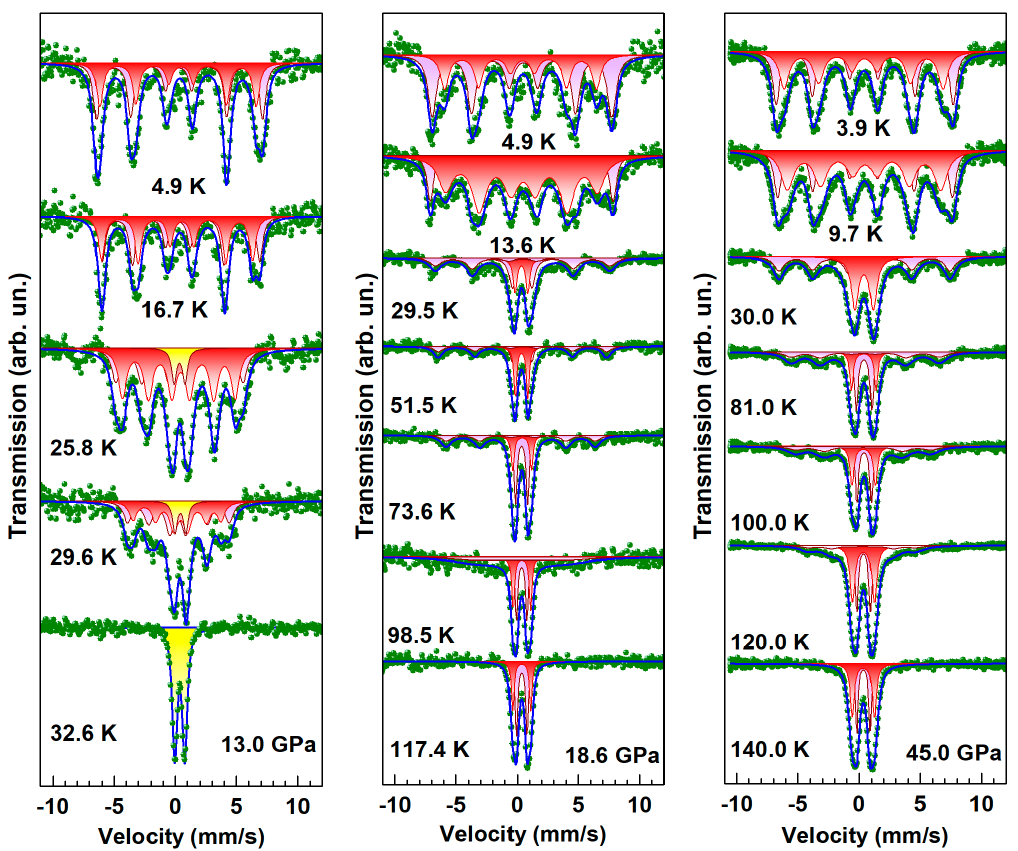
Figure 7. (Colour on-line) Evolution of SMS spectra with temperature in Ba 3 NbFe 3 Si 2 O 14 at pressures below (13.0 GPa) and above (18.6 and 45.0 GPa) the structural transition at about P = 17.5 GPa. Color lines are the calculated subspectra fitted to the experimental points (dots).